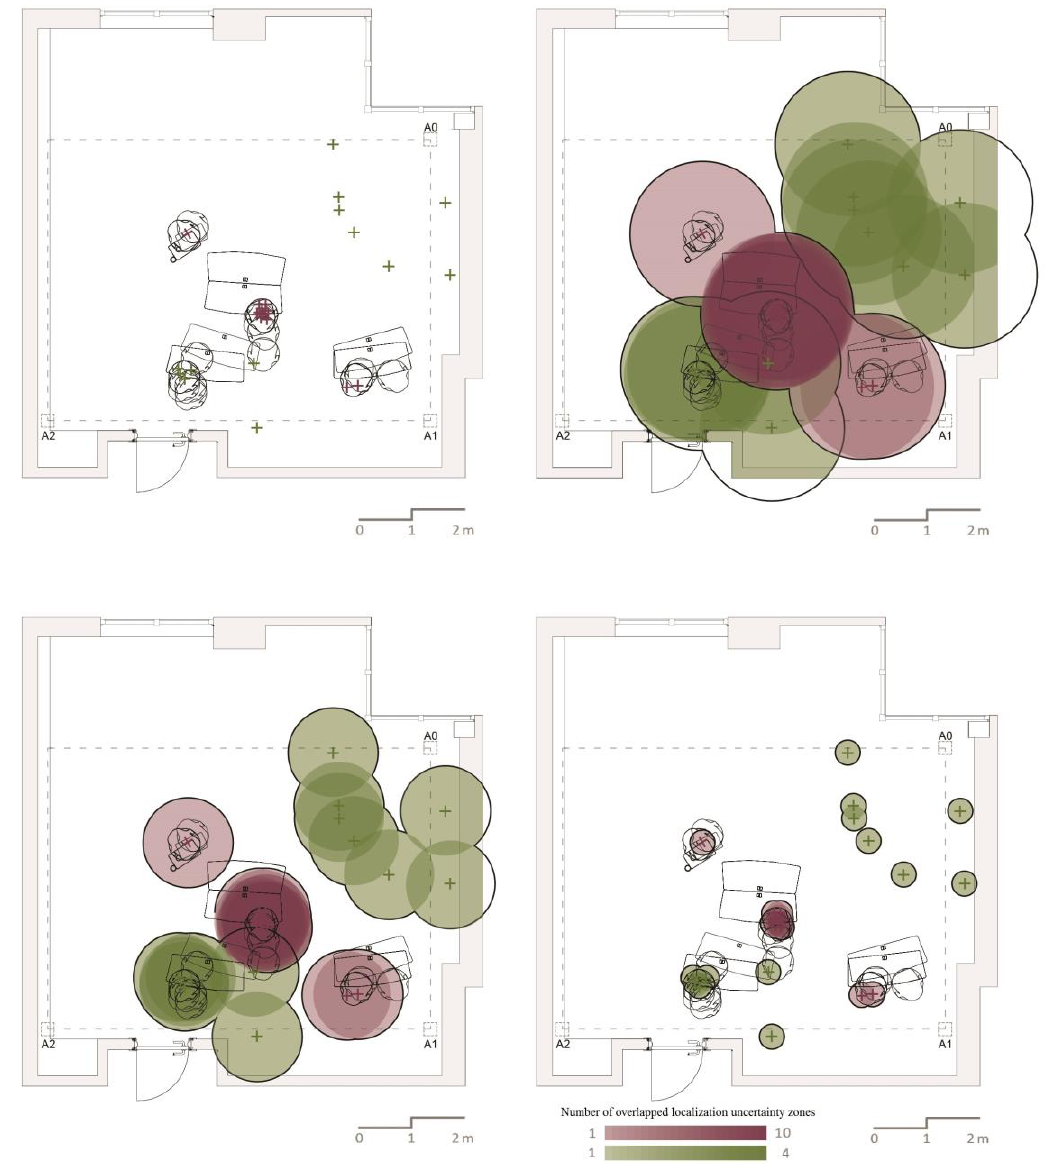
Figure 6. Simulation of observations using the three tested technologies. This simulation was made by incorporating the real locations of two students selected from a behavioral dataset collected from an active learning classroom during a three-hour workshop. From left to right, top to bottom: real locations, Wi-Fi, BLE beacon and UWB.